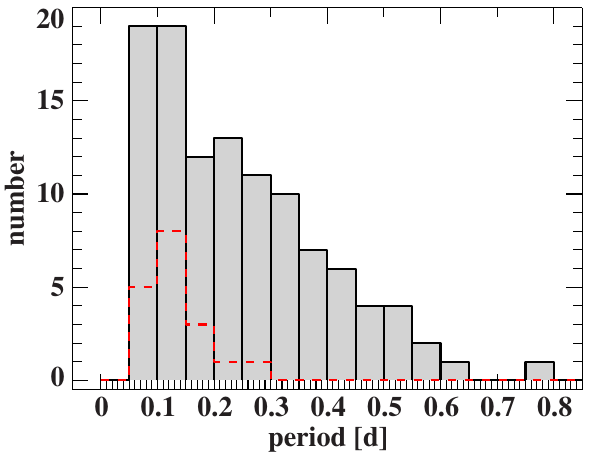
Figure 4. Period distribution of the OGLE HW Vir candidates in com- parison to the known HW Vir systems. The OGLE systems are shown in grey and the known systems by the red dashed line.